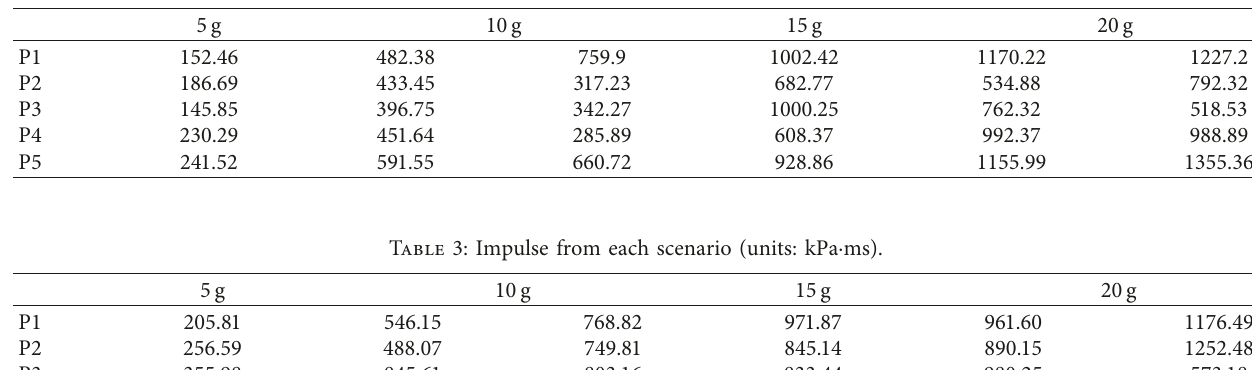
Figure 11: Experiment data from scenario T4 (20 g TNT). (a) Test data from P1. (b) Test data from P5. (c) Test data from P2. (d) Test data from P4. (e) Test data from P3. Table 2: First peak overpressure from each scenario (units: kPa).